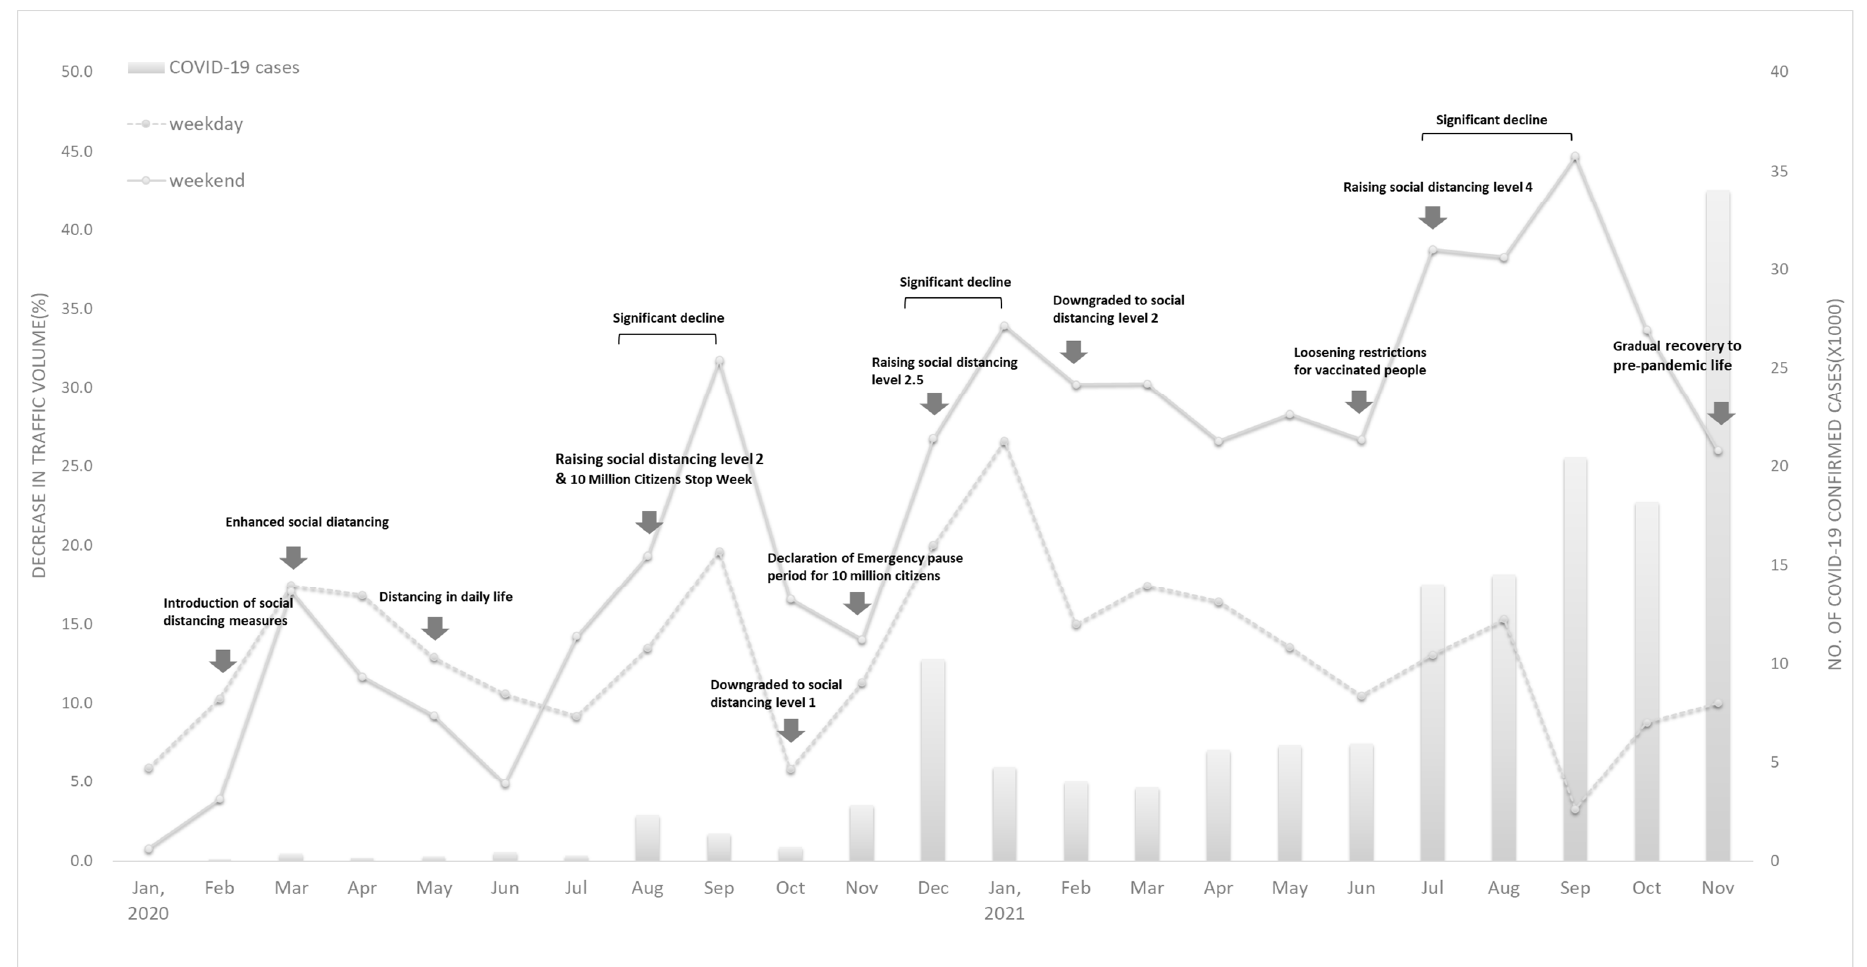
Figure 2. Monthly number of confirmed COVID-19 cases in Seoul (source: https://www.seoul.go.kr/coronaV/coronaStatus.do (accessed on 25 May 2022)) and monthly decrease rates of traffic volume at Sinchon Station. The left y-axis corresponds to rate of traffic volume decrease, and the right y-axis corresponds to the number of confirmed COVID-19 cases. The black line and gray dotted line indicate the rates of traffic volume decrease between 2019 and 2020, and between 2019 and 2021,